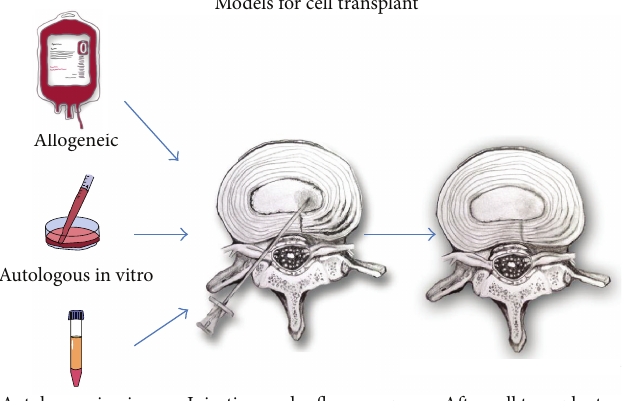
Figure 2: Models for mesenchymal stem cell (MSC) concentration and/or isolation prior to fluoroscopically-guided intradiscal injection.